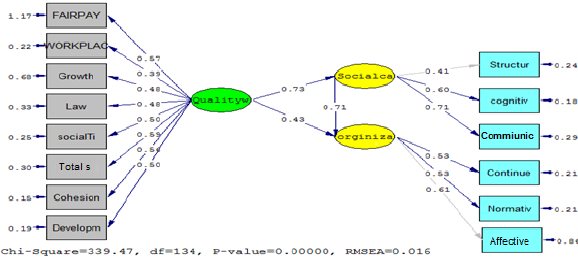
Fig. 3. The results of t-value statistics in the final model confirmation on the relationship between work life quality, social capital and organizational commitment